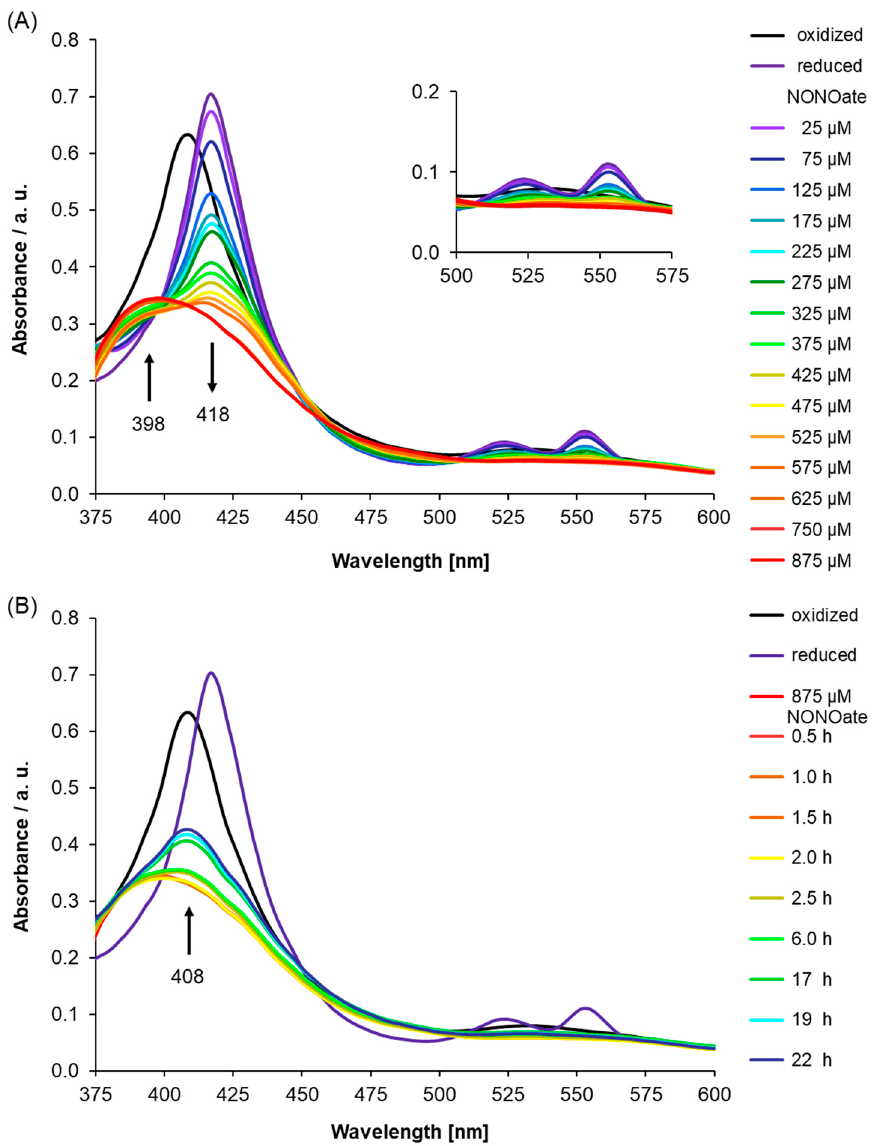
Figure 3. ( A ) Nitric oxide (NO) binding was monitored after the addition of diethylamine / nitric oxide complex (DEA NONOate) (NO donor) to reduced Light Response Bric-a-Brac / Tramtrack / Broad Complex (AtLRB3) (400 µ g / mL protein) under anaerobic conditions. On reduction by sodium dithionite (8 mM), the Soret peak shifts by ~10 nm to 418 nm and the β - and α -peaks appear at 525 and 553 nm. Subsequent addition of NO results in a noticeable change of the UV / Vis spectra. The signature of the ferrous heme (Soret and β - and α -peaks) vanishes with an increasing concentration of the NO donor, while a broad peak at 398 nm appears, indicating a 5c nitrosyl heme center. Addition beyond 625 µ M of NO donor does not result in further spectral changes, indicating the formation of NO-saturated protein. (black: oxidized, dark violet: reduced, violet–red: NO addition in increments) Inset: Highlights α - and β -peak regions. ( B ) The spectral behavior of AtLRB3 after NO-saturation (post-NO saturation, pNs) was monitored under anaerobic conditions. UV / Vis spectra were recorded at several time points. NO dissociates slowly from the heme and results in the reappearance of the Soret peak at 408 nm, which is characteristic of the oxidized (ferric) state of heme iron. UV / Vis spectra of the ferric and ferrous protein are included for comparison. (black: oxidized, dark violet: reduced, red: NO-saturated protein, dark red–blue: pNS measured at several time points). The inset of Figure 3A shows the characteristic α - and β -peaks of the oxidized and reduced protein. The observed Soret peak and split β - and α -peaks suggest the presence of an unknown sixth ligand coordinated to the ferrous heme center similar to the absorption values reported during the purification of sGC versions